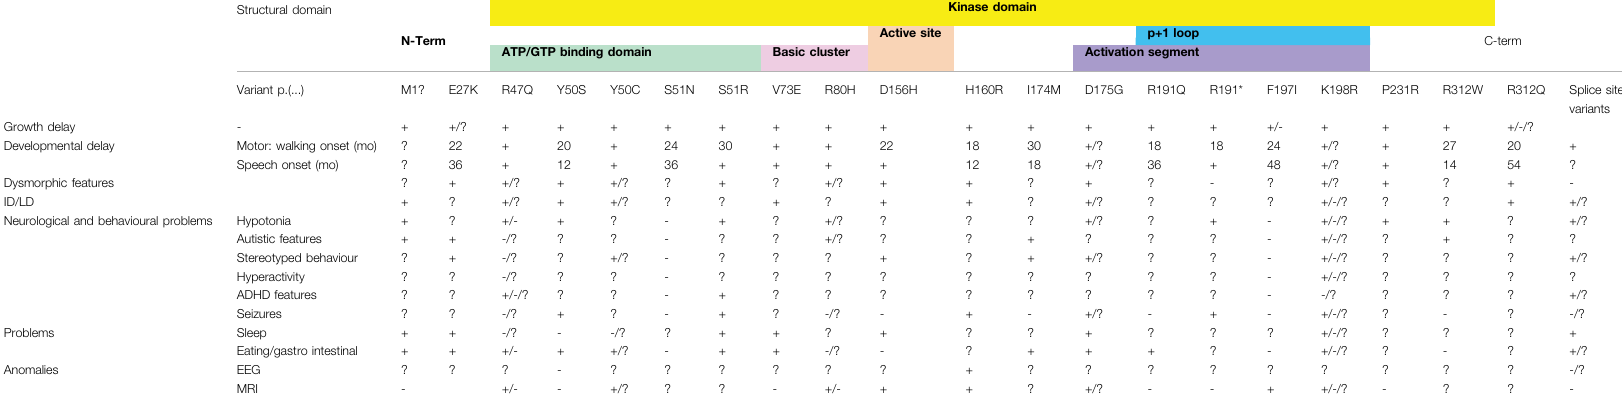
TABLE 2A | OCNDS patients and their symptom pro fi les. Structural domain Kinase domain N-Term Active site p+1 loop C-term ATP/GTP binding domain Basic cluster Activation segment Variant p.(...) Growth delay Motor: walking onset (mo)